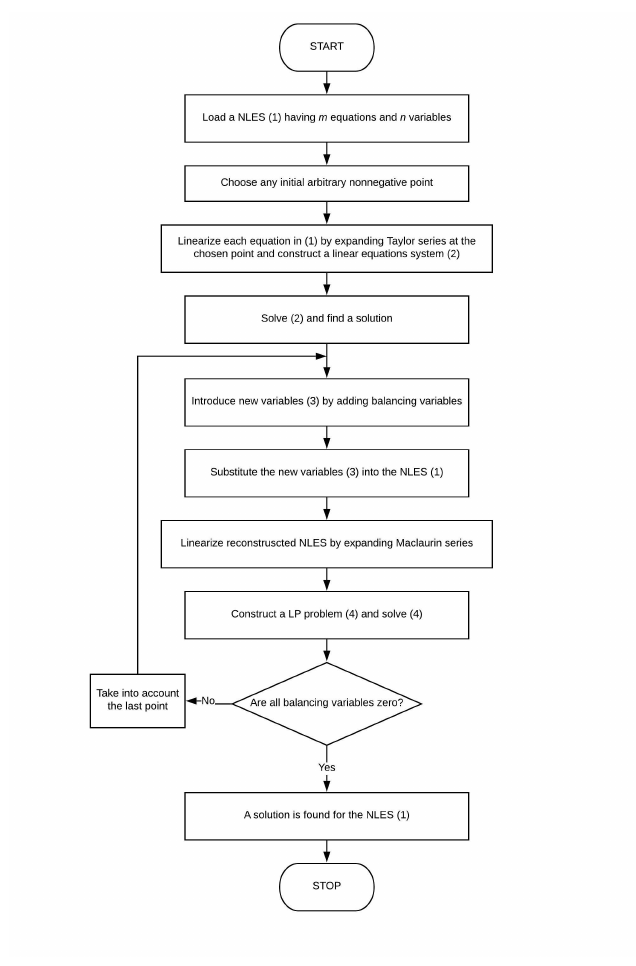
Figure 1. The flowchart of finding solution of